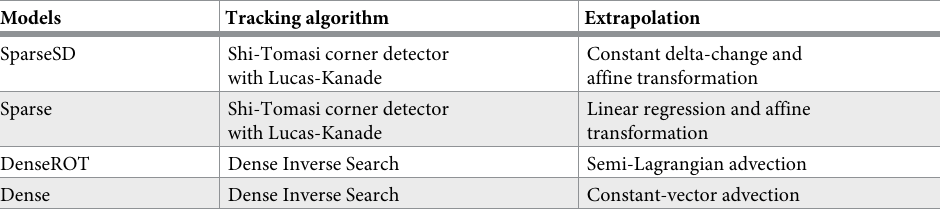
Table 3. Overview of the four baseline methods based on optical-flow algorithm.